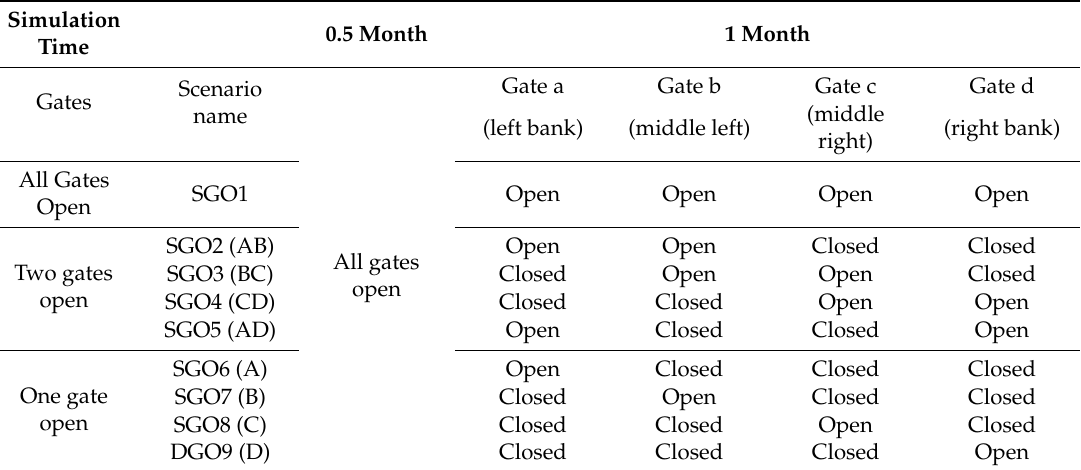
Table 4. Gate operation scenarios.